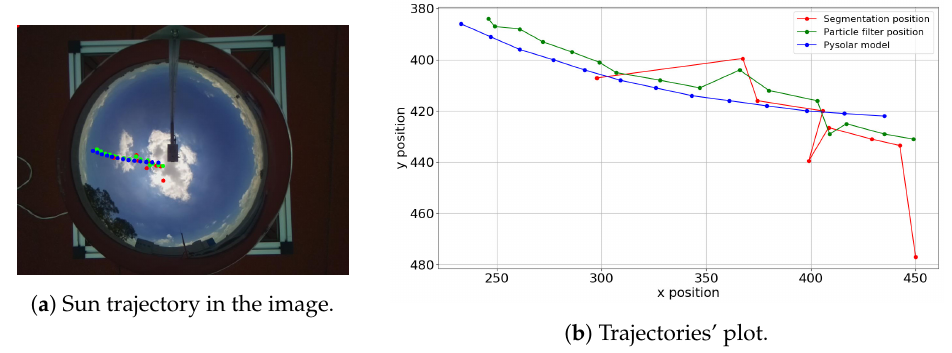
Figure 21. Trajectory of the Sun during the evaluated period of time